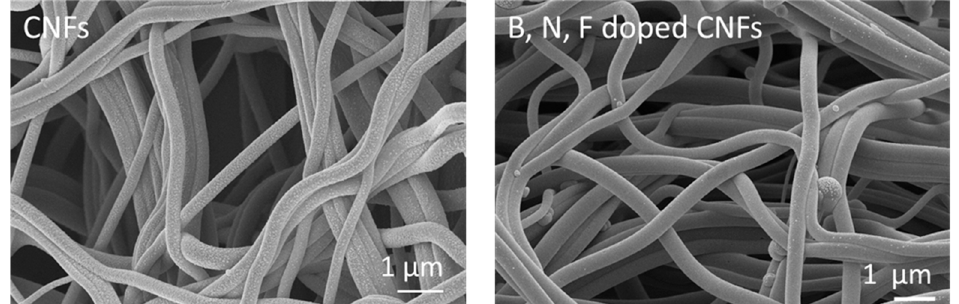
Figure 6. SEM images of centrifugally spun CNFs and B, N, F-doped CNFs.